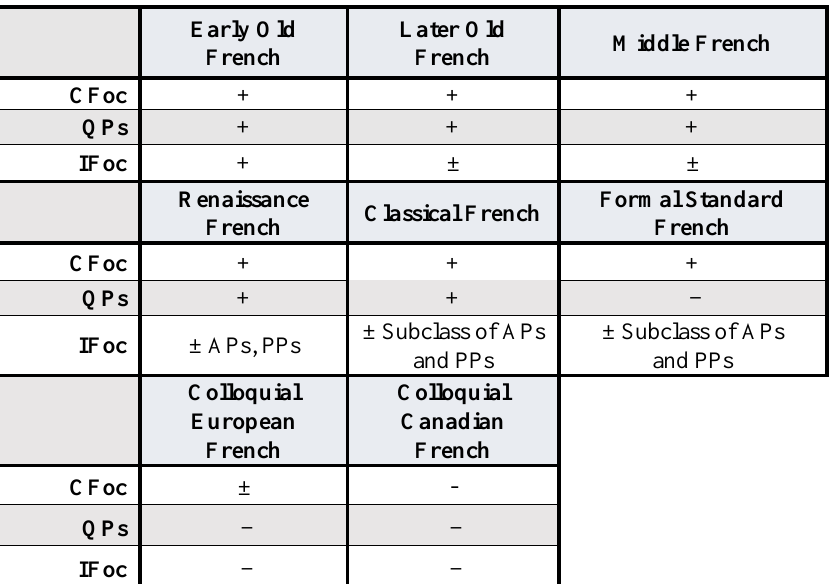
Table 2. Left-Peripheral Focus in French Varieties Past and